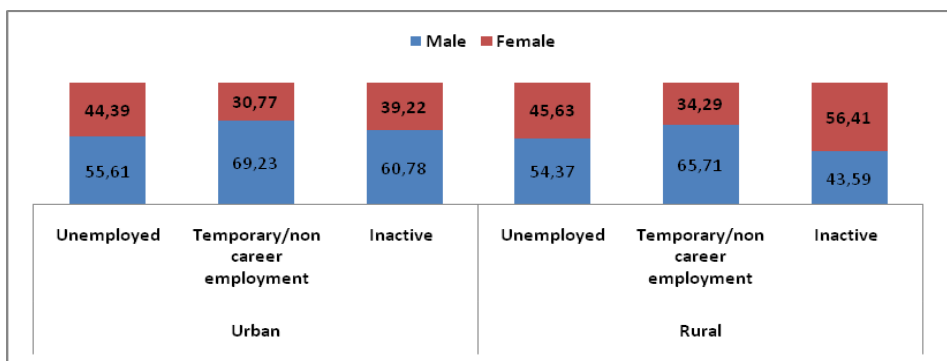
Figure 11: Youth in transition by sub-category and gender and area of residence (%)